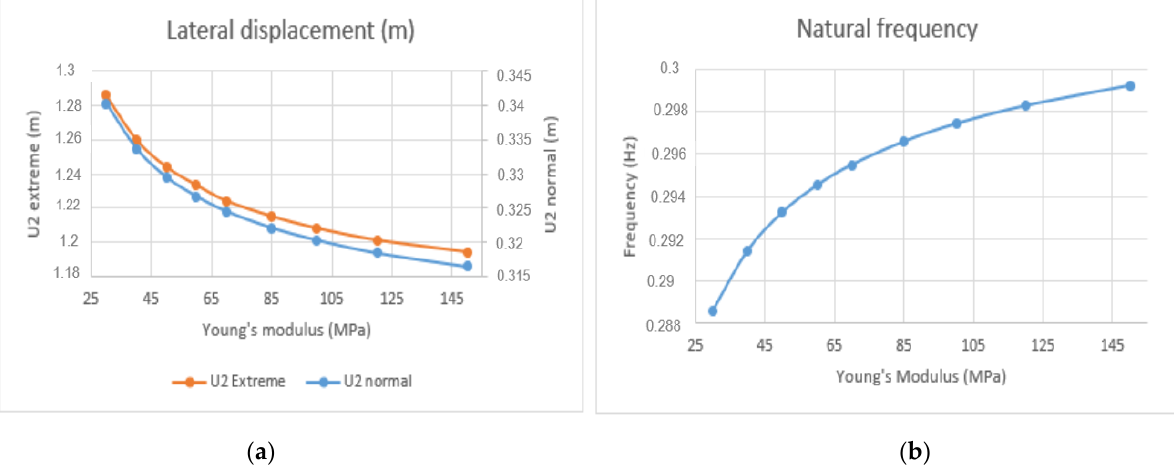
Figure 16. Influence of Young’s modulus E: ( a ) Lateral displacement, ( b ) Natural frequency.